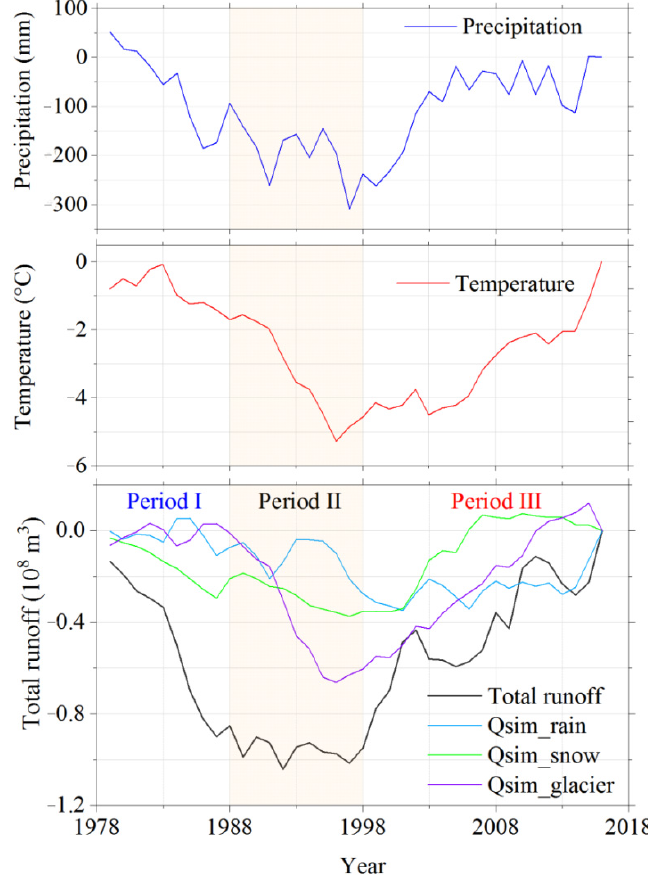
Figure 10. Comparison of the accumulated curves for temperature, precipitation, total runoff, Qsim_rain, Qsim_glacier and Qsim_snow. Period II is indicated by the light orange.